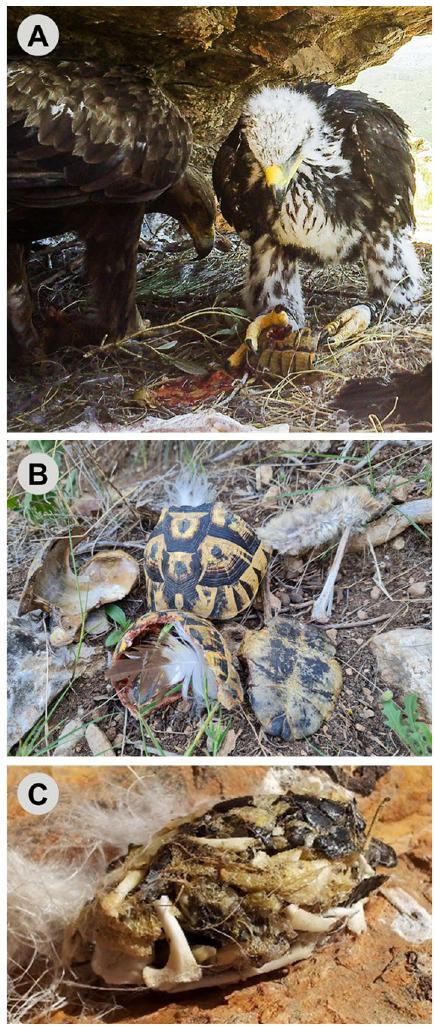
shell. ( A ) A golden eagle nest (adult and juvenile individuals) with spur-thighed tortoise Testudo graeca remains in SE Spain (photo: Mario León-Ortega). ( B ) Broken carapaces of spur-thighed tortoise below a golden eagle nest in SE Spain (photo: Andrés Giménez). ( C ) A golden eagle pellet, consisting entirely of spur-thighed tortoise remains, from an eagle roost in SE Spain (photo: Marcos